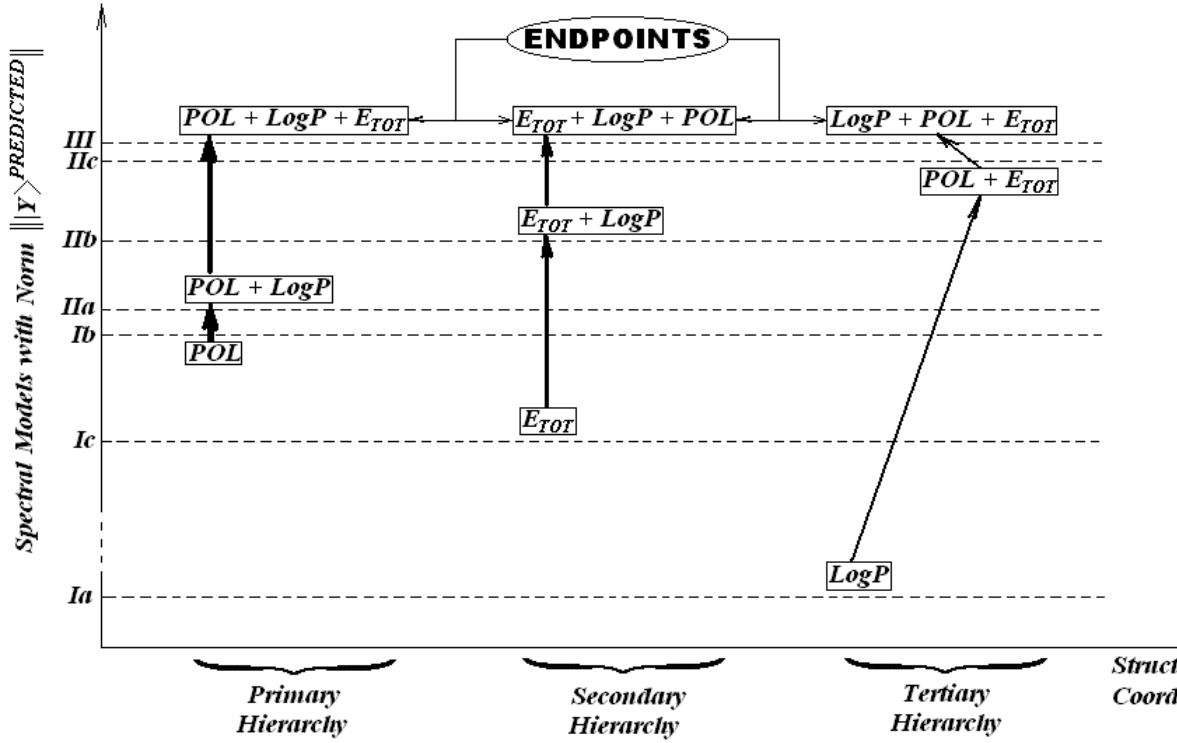
Figure 5. Spectral-structural models, designed through the rules of minimal spectral-SAR paths of Table 7, emphasizing the primary, secondary and tertiary hierarchies forward the endpoints of the Tetrahymena pyriformis eco-toxicological activity according with data of Table 3, S-SAR equations of Table 5, and of the associated spectral norms computed upon Eq.